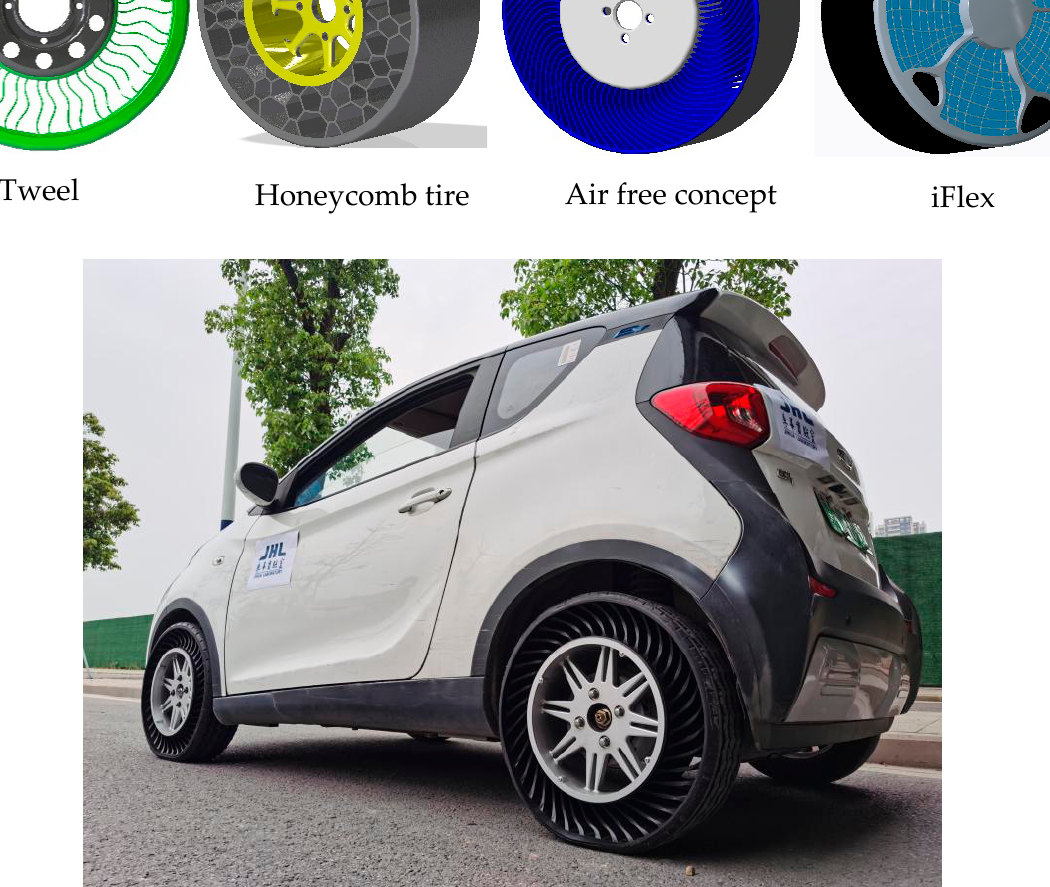
Figure 1. Nonpneumatic tires.